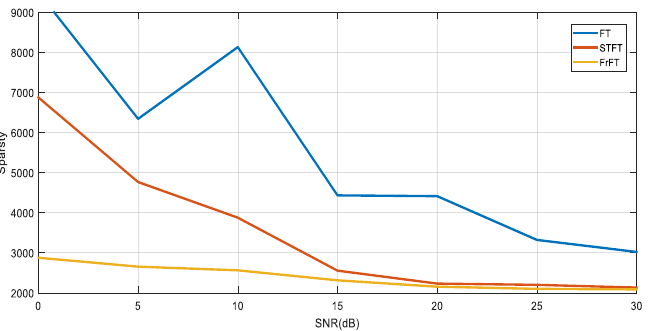
Figure 10. Sparsity comparison at different SNRs after different transformations (single time).